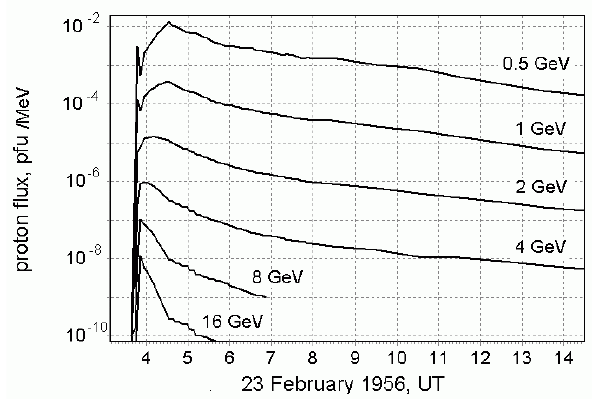
Fig. 8. Behavior of the power law index (exponent) for isotropic (starting from the 16th 5-min interval), and anisotropic (the first 15 five-min intervals) models, together with mean flux, averaged by all directions (for 1GeV energy).